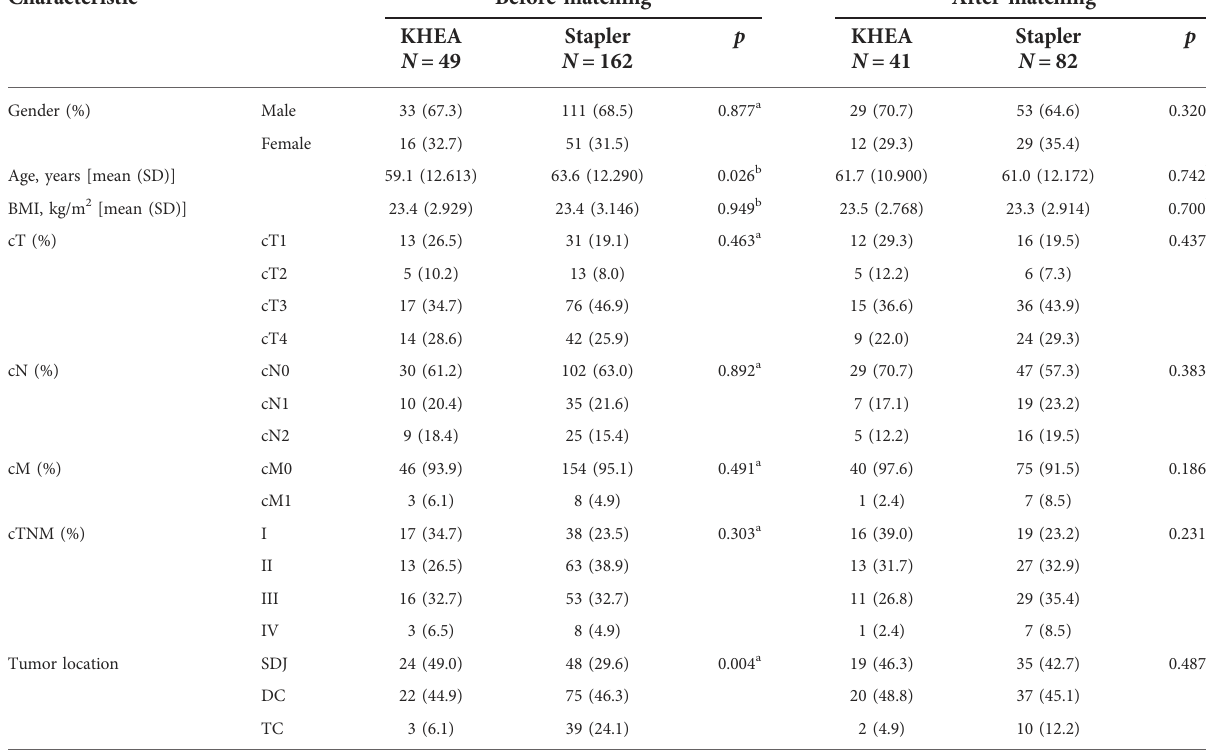
TABLE 1 Demographic and clinicopathologic characteristics. Characteristic Before matching After